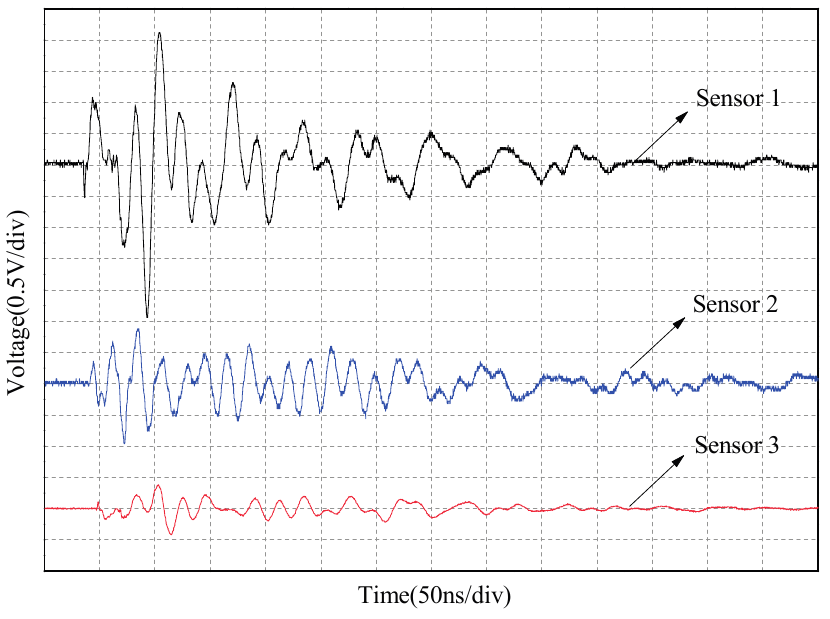
Figure 18. Time-delay experiment waveforms of three ESA